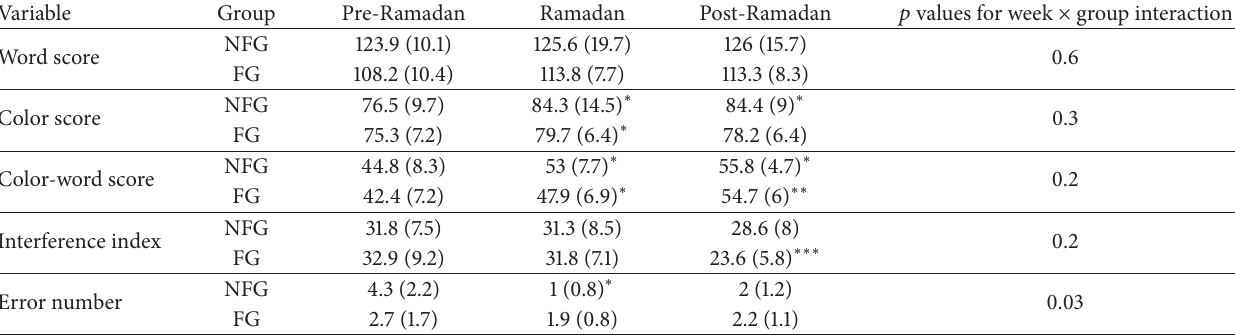
Table 1: Stroop test scores at three occasions in fasting group (FG) and nonfasting group (NFG) (mean values with standard deviations in parentheses).